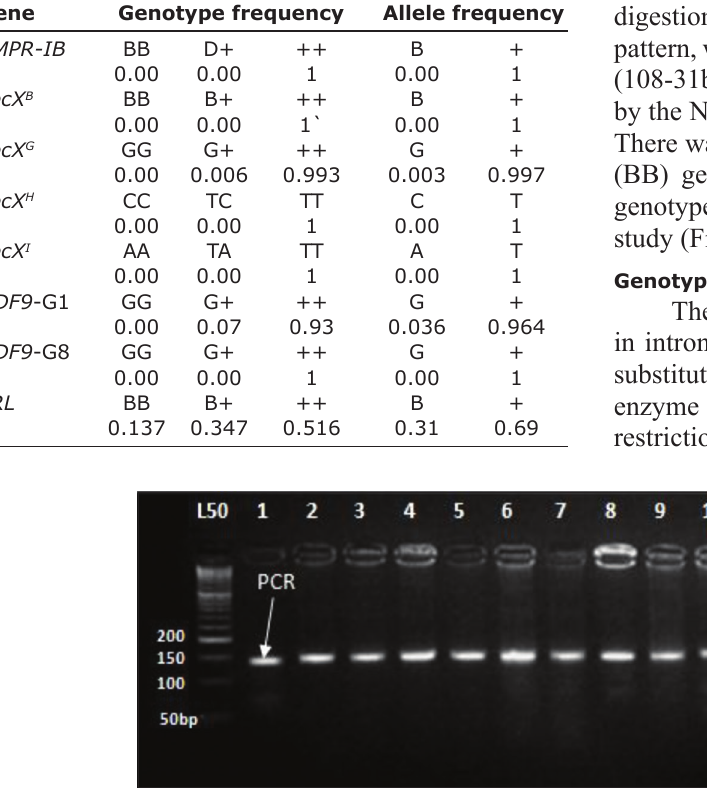
Figure-1: Agarose gel electrophoresis (4%) displaying Ava II1restriction site on an amplified portion of Watish BMPR1B gene in exon 6. Lane 1: Polymerase chain reaction product. Lane 2-14: Restriction enzyme representing BB genotype (140 bp). Lane L: 50 bp DNA ladder.